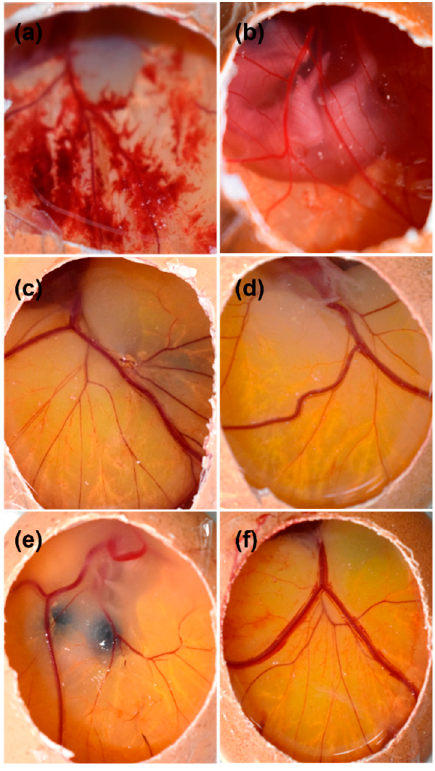
Figure 9. Images of the hen’s egg test on chorioallantoic membranes (HET-CAM) 5 min post-instillation of different samples, namely ( a ) NaOH (C+), ( b ) NaCl (C − ), ( c ) drug-free F6, ( d ) drug-free F7, ( e ) F6, and ( f ) F7.